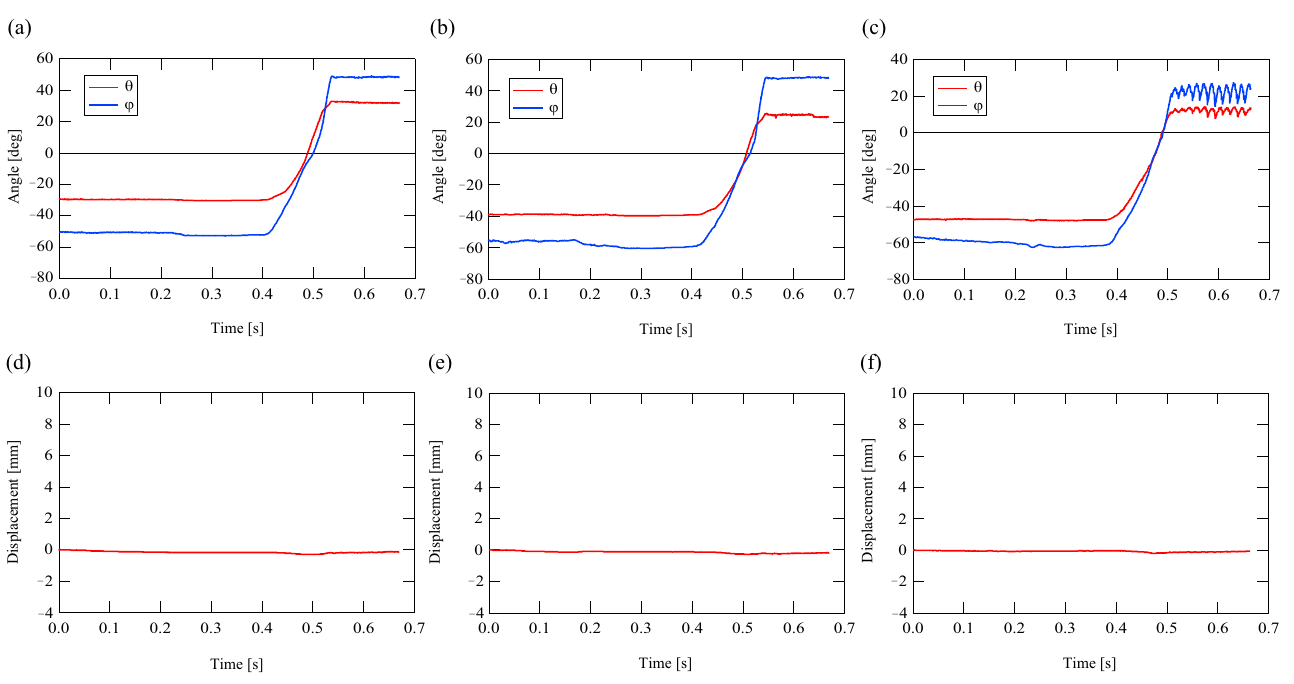
Figure 13. Experimental results around the reversal point with zero and nonzero attack angles. ( a ) Angular displacements of two links with zero attack angle. ( b ) Angular displacements of two links with 10-degree attack angle. ( c ) Angular displacements of two links with 18-degree attack angle. ( d ) Variation of y -coordinate of the tip with zero attack angle. ( e ) Variation of y -coordinate of the tip with 10-degree attack angle. ( f ) Variation of y -coordinate of the tip with 18-degree attack angle. There are quantitative discrepancies between the theoretical and experimental